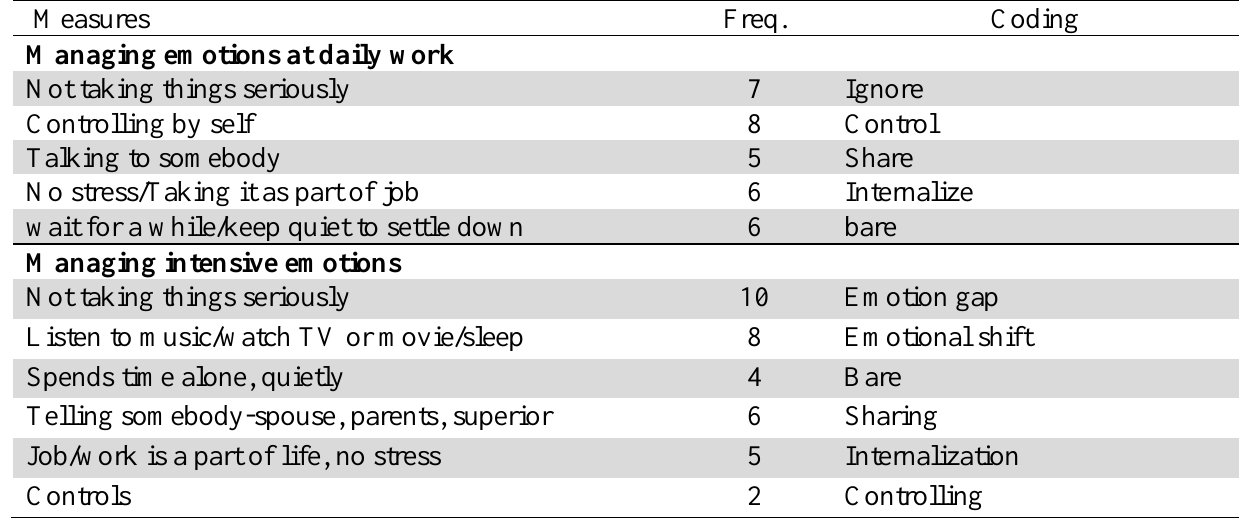
Strategies used by Nurses for Maintaining Emotional Stability Measures Freq.